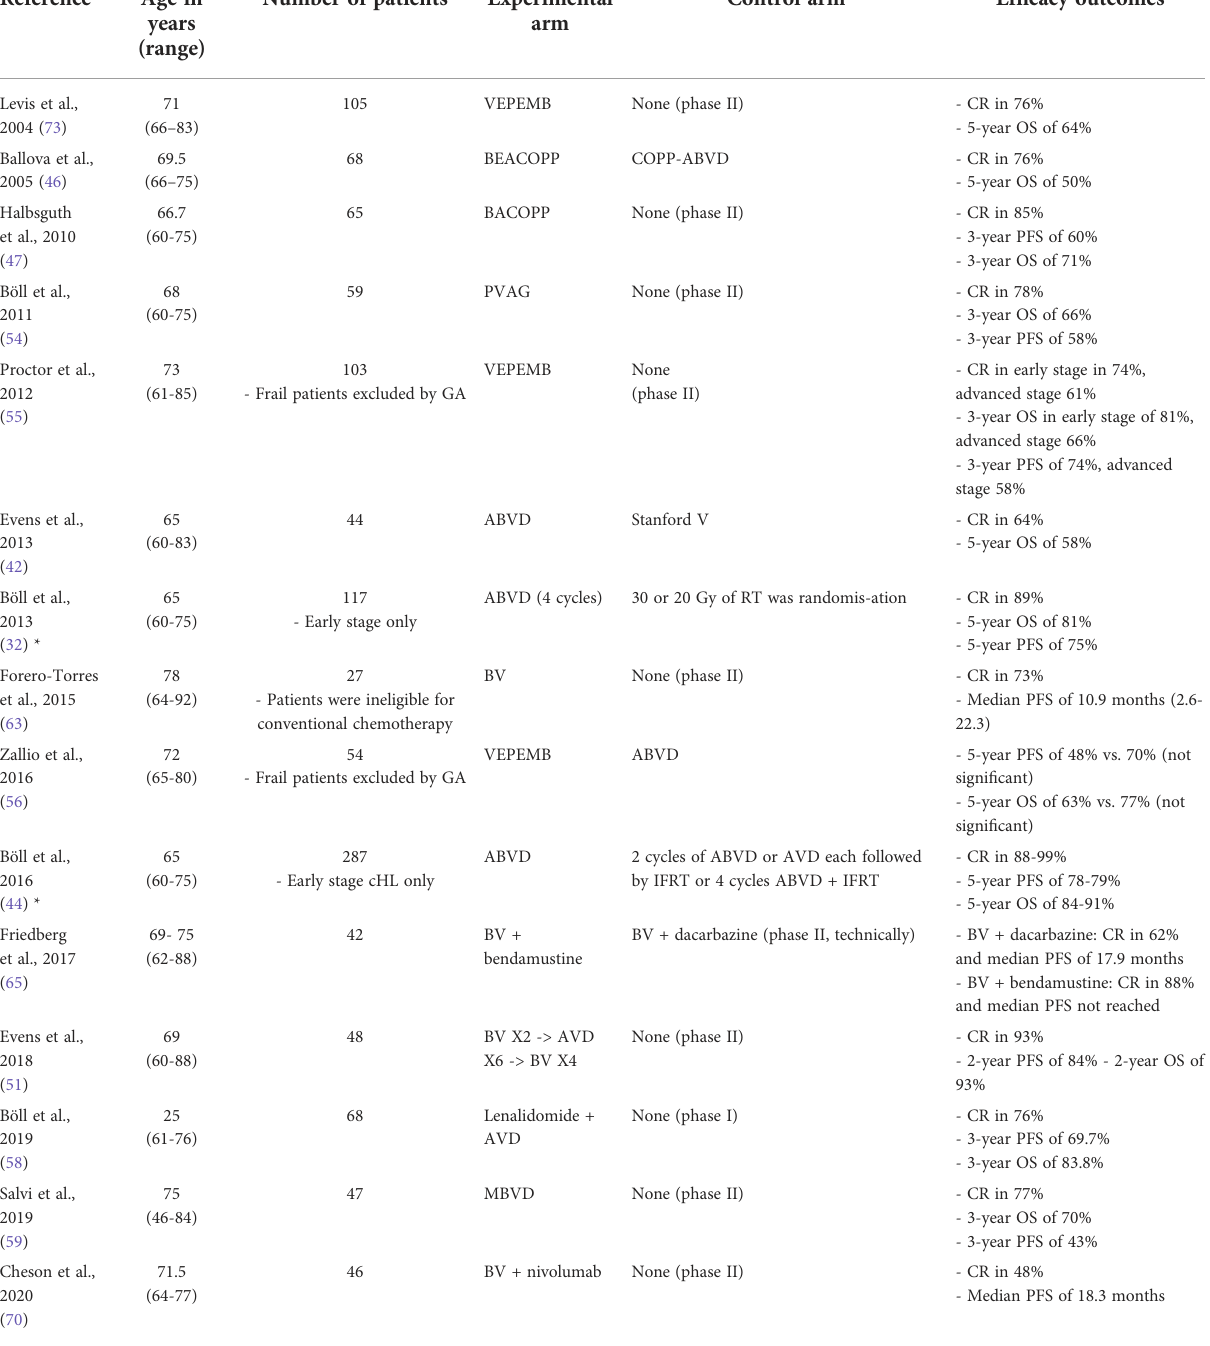
TABLE 1 Comparison of prospective trials regarding upfront treatment of older patients with classical Hodgkin lymphoma